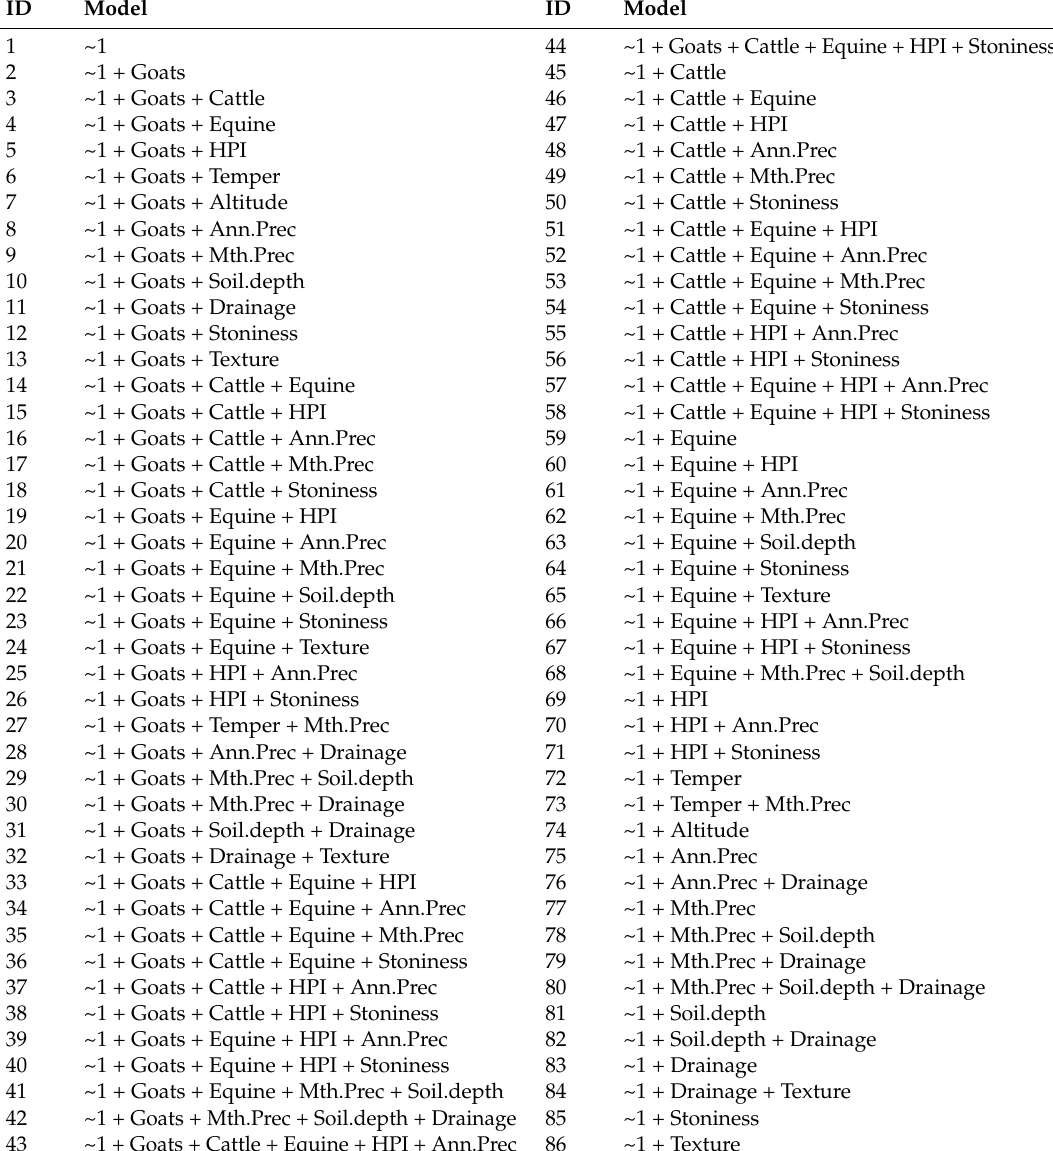
Table A1. Candidate Models (Constructed from Predictor Variables